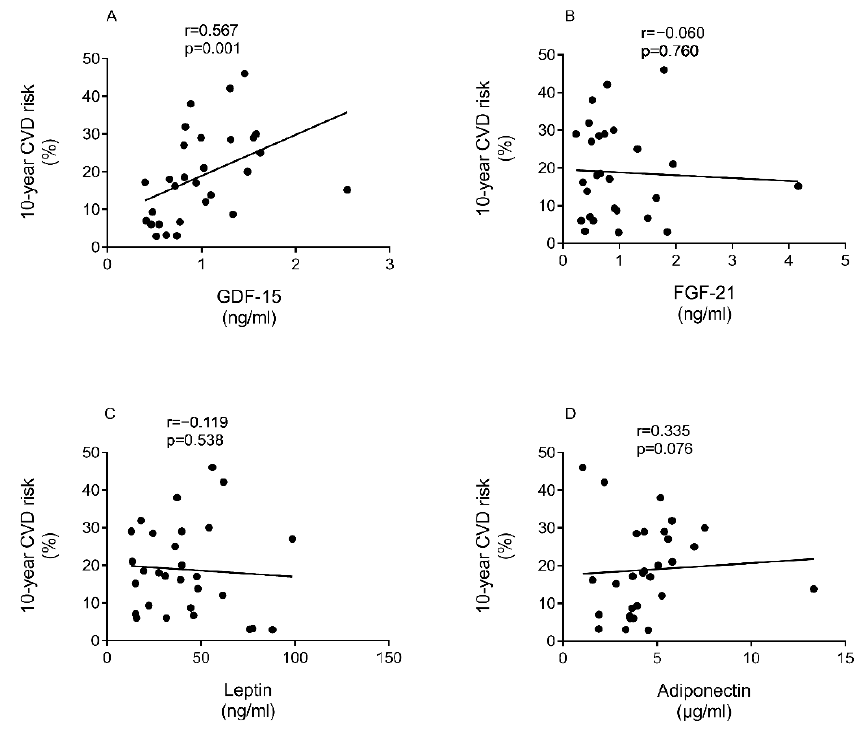
Figure 3. Correlation between CVD risk and plasma biomarkers at baseline in terms of 10-year CVD risk with GDF-15 ( A ), FGF-21 ( B ), Leptin ( C ), and Adiponectin ( D ). Twenty-nine participants (12 responders/17 non-responders) were included. Spearman Rho/Pearson Correlations were used as appropriate. Correlations were done at baseline, there was no change in relationship over time.